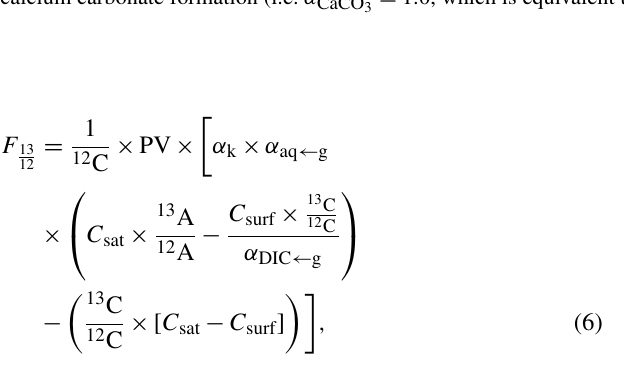
Figure 2. Schematic overview of the 13 C implementation in FAMOUS. Blue boxes represent permanent carbon pools. Grey boxes represent temporary carbon pools (note that CaCO 3 is a temporary carbon pool because the export of CaCO 3 in FAMOUS is represented as an instantaneous redistribution of alkalinity and carbon at depth). The orange box represents the prescribed atmospheric carbon pool. The dashed lines represent fluxes of 13 C / 12 C. However, note that the outgassed 13 C / 12 C has no effect on δ 13 C atm because FAMOUS does not currently have a fully interactive carbon cycle. Solid lines represent fluxes of 13 C. Dot-dashed lines represent processes that occur below the lysocline ( ≈ 2500m below sea level). The dotted line represents the reflux of detrital material from the seafloor to the surface layer. Red lines represent fractionation effects. The orange line represents isotopic fractionation during calcium carbonate formation ( α CaCO ), which 3 is included in the code as a user-specified constant. Note that all simulations presented in this study were run without fractionation during = 1 . 0, which is equivalent to a fractionation effect of 0‰). calcium carbonate formation (i.e. α CaCO 3